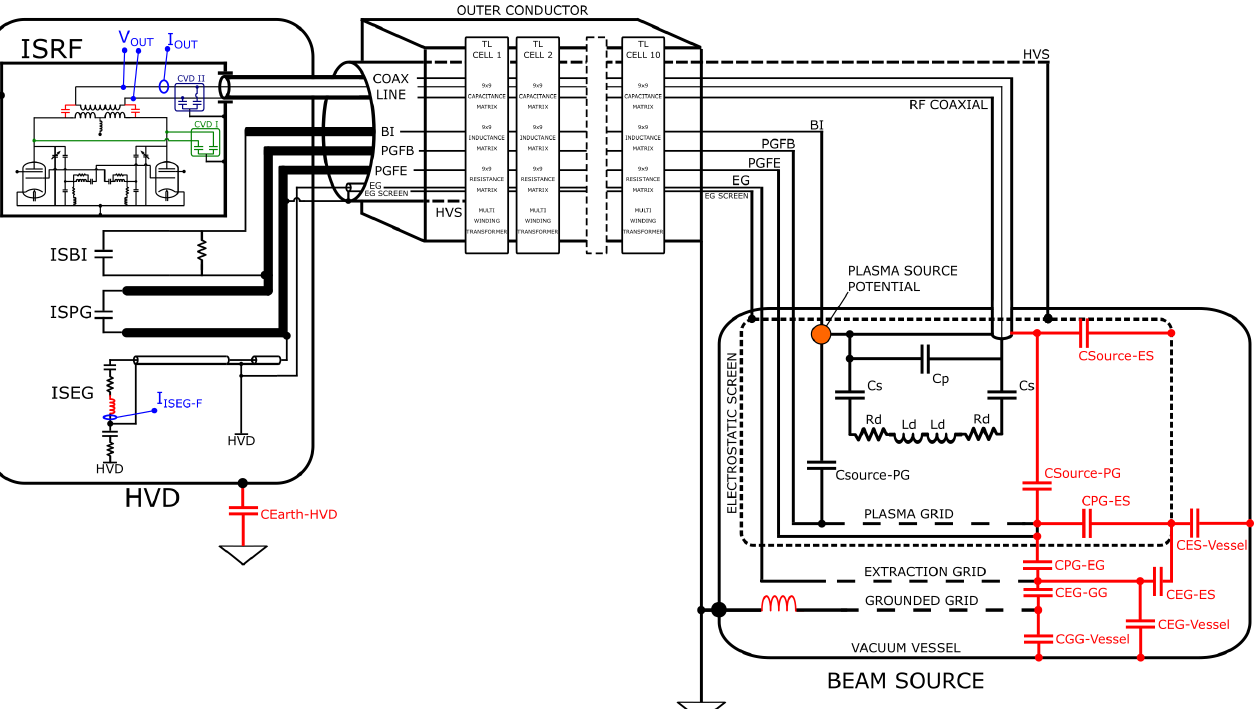
Figure 6. Complete scheme of the circuital model. In red, the stray elements, and in blue, the position of the voltage and current measurements ( V OUT , I OUT , I ISEG − F